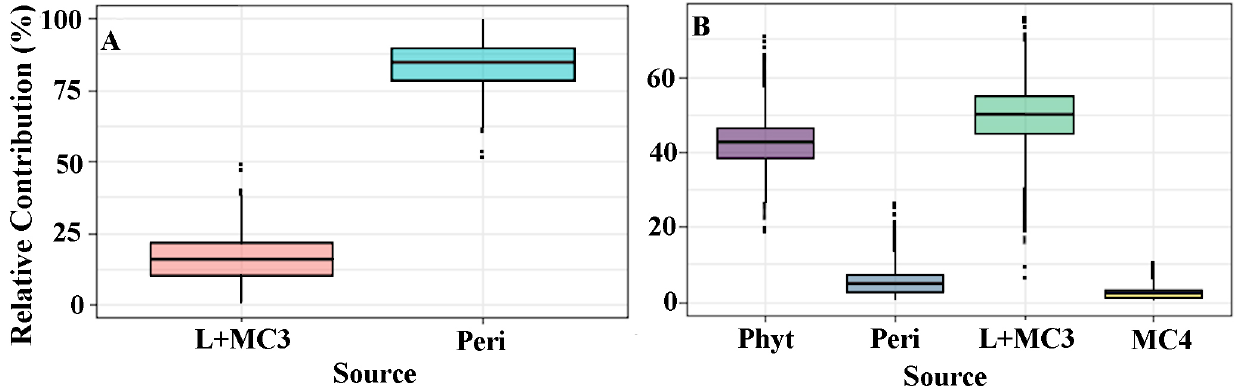
FIGURE 4 | Relative contributions (%) of autotrophic energy sources of Semaprochilodus insignis collected from two Amazonian rivers, in Amazonas, Brazil . A. Negro River; B. Solimões River. L+MC3 = Group of leaves + Macrophyte; Peri = Periphyton; Phyt = Phytoplankton; MC4 = C 4